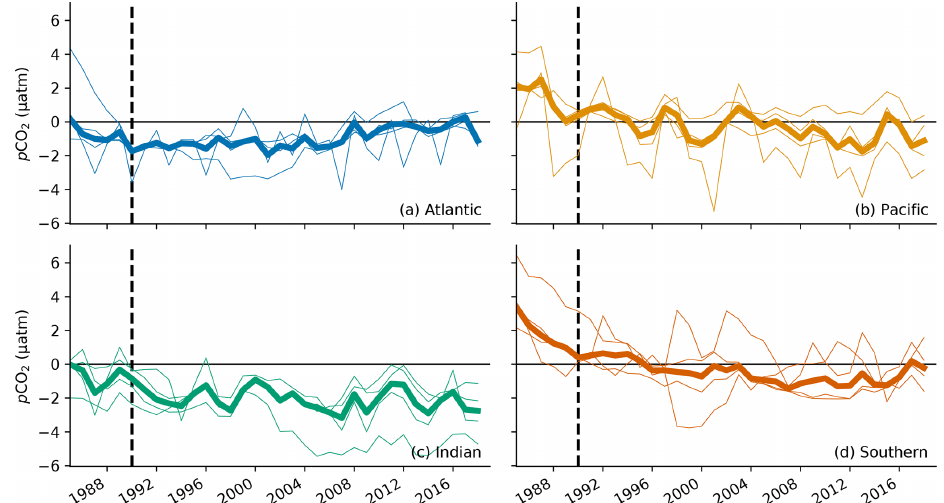
Figure 9. A basin–mean comparison of OceanSODA-ETHZ p CO 2 with four gap-filling methods: MPI-SOMFFN, JENA-MLS, CMEMS- FFNNv2, and CSIR-ML6. The thin lines show the differences compared to the individual methods, while the thick line shows the mean difference across the four methods. We do not show the Arctic Ocean as OceanSODA-ETHZ covers only 23% of the region. The vertical dashed line in each figure marks the year 1990, where estimates prior to this period show biases in panels (b) and (c)